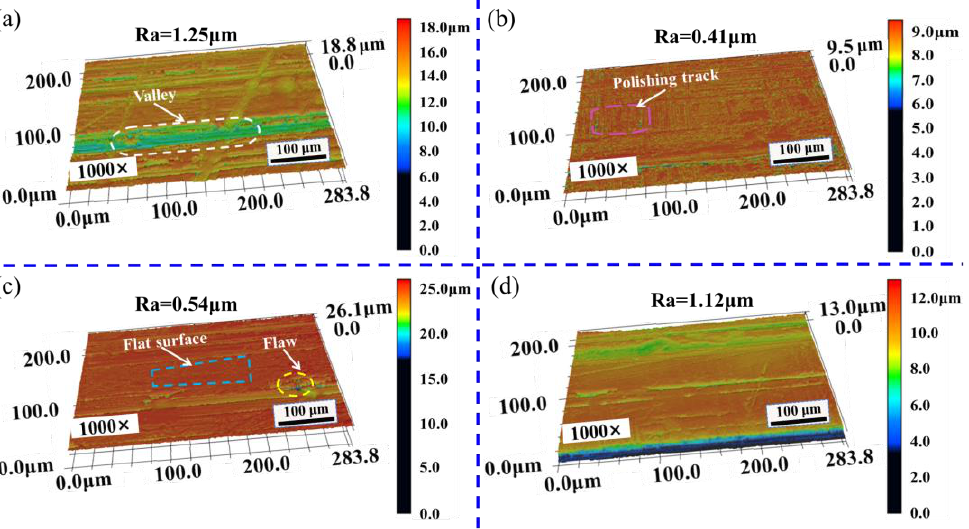
Figure 10. Three-dimensional morphologies of polished surface under different spot overlap ratios after cleaning. ( a ) 99.52%; ( b ) 98.55%; ( c ) 97.58%; ( d ) 96.62% (observed by LSCM at 1000× magnifi-